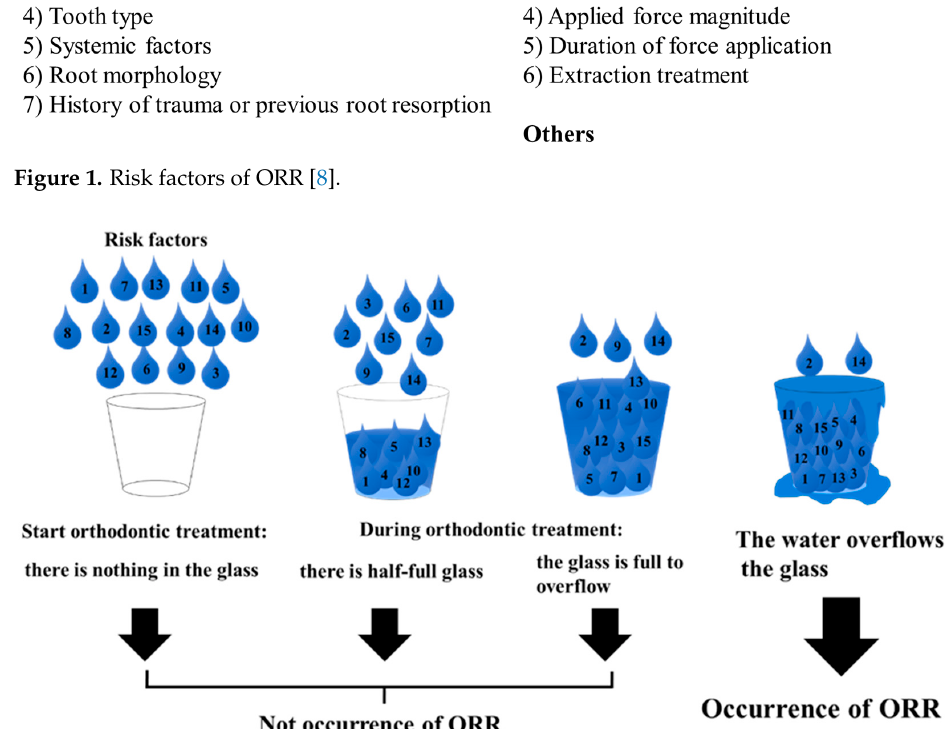
Figure 2. The schema of occurrence of ORR. A gradual increase in the number of risk factors (water droplets) following orthodontic treatment slowly leads to root resorption (Figure 2).